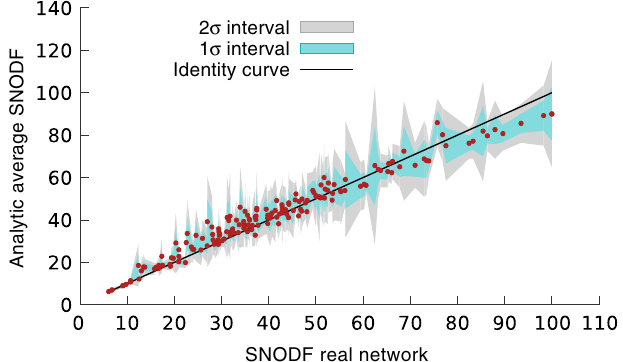
FIG. 9. Comparison between the real measure of the stable NODF and its average in the ensemble estimated using an analytical expression for the 167 networks of our study.